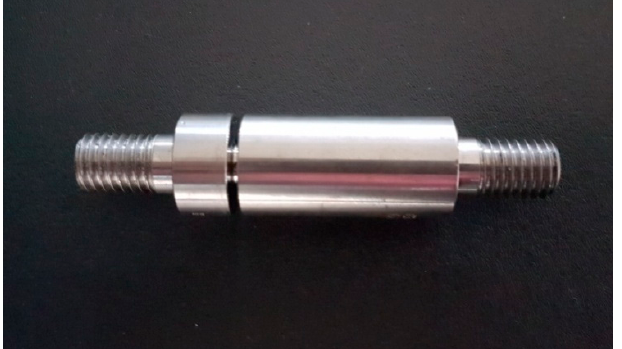
Figure 12. Set after pressing.